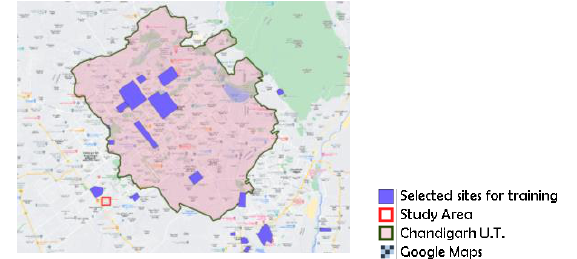
Figure 8. Google Satellite base layer -in High density area